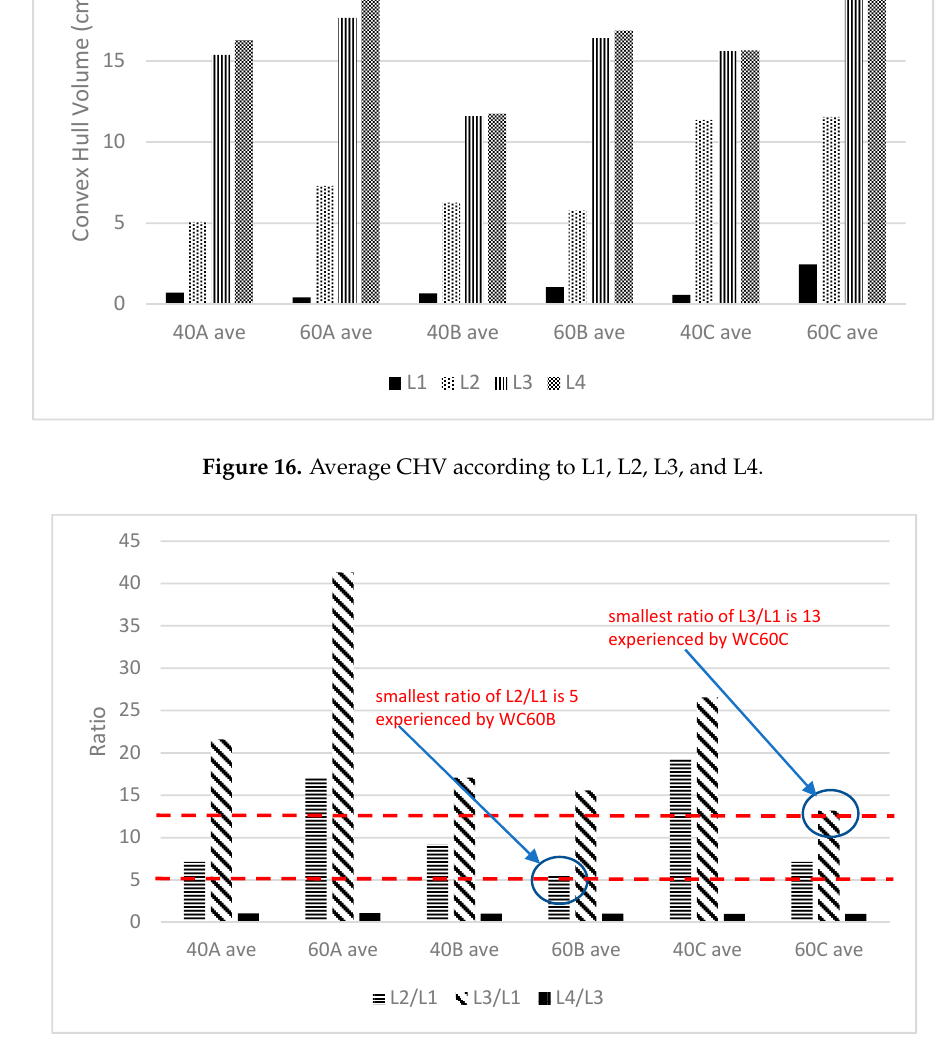
Figure 17. Ratio of CHV L2/L1, L3/L1, and L4/L3.